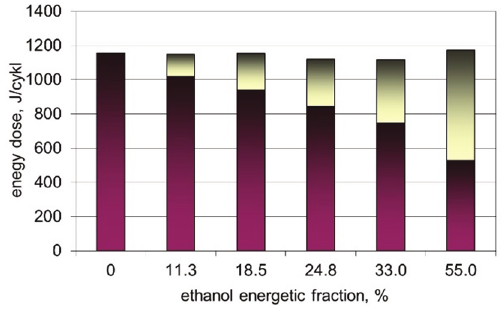
Fig 4. Heat release rate